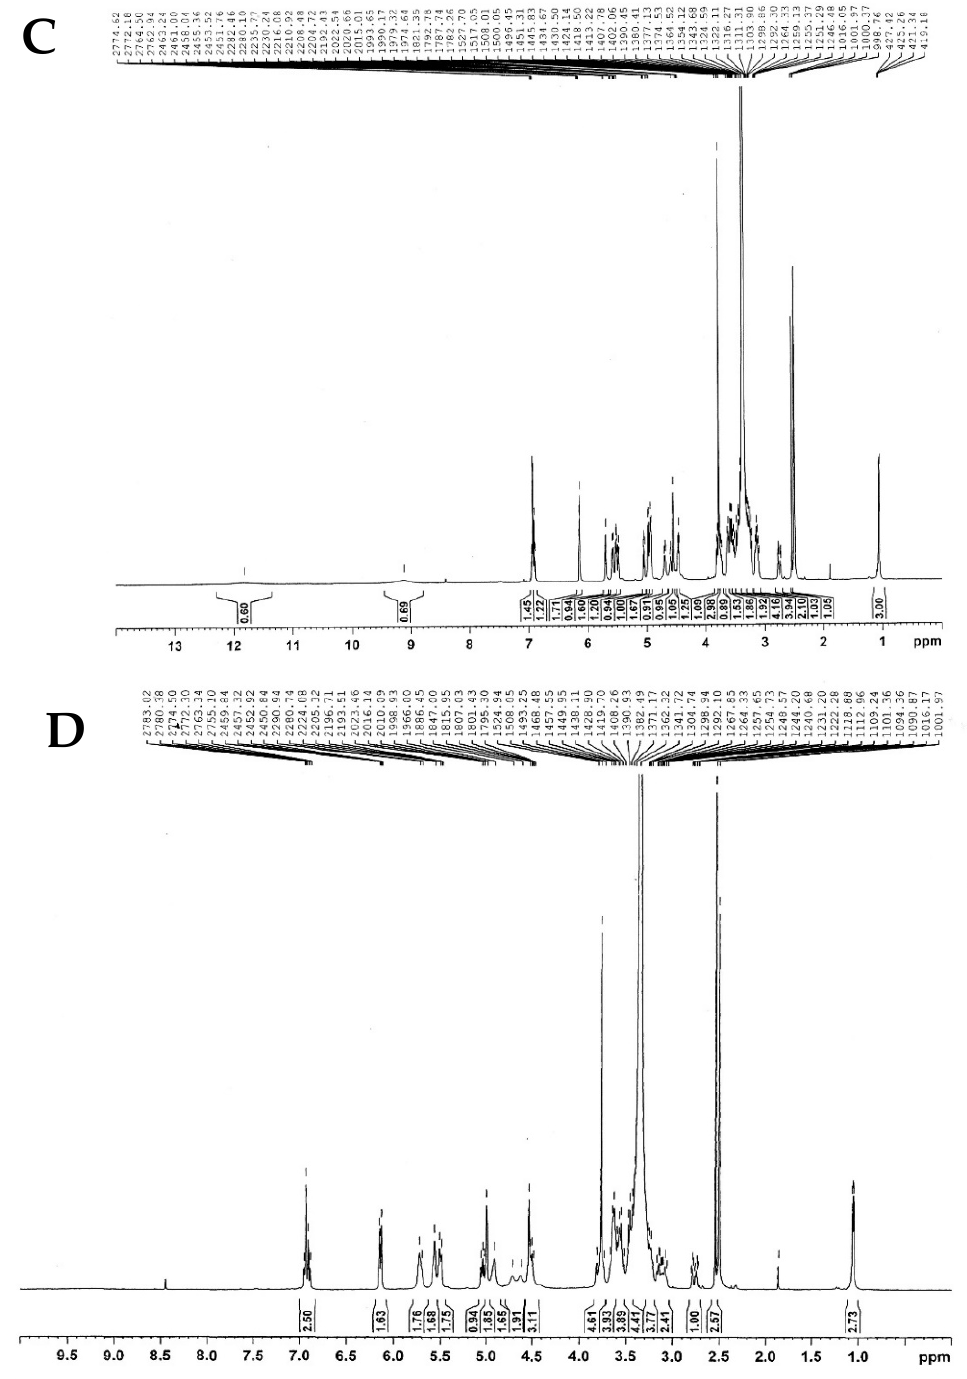
Figure 4. The 400 MHz 1 H-NMR spectra of ( A ) hesperetin, ( B ) hesperidin, ( C ) HG 1 , and ( D ) HG 2. In 13 C-NMR spectra, carbon signals for glycoside products at R t of 6.2 and 7.7 min were assigned to hesperidin glycosides. The peaks of HG 1–2 with chemical shifts at 60–61 ppm (–CH 2 OH), 103–197 ppm (aromatic carbon), and 99–101 ppm (α-anomeric carbon of glucose) were observed (Table 1 and Figure S1). From the result, the α-configuration of the D-glucose residue in HG 1 was identified by anomeric carbon of the glucose II signal (position C-1*) (Table 1 and Figure 5), which shifted from 92.77 to 101.25 ppm. In addition, comparing the position C-4″ of glucose I of hesperidin and HG 1 indicated that the carbon sidic form. For the 13 C-NMR spectrum of HG 2 , another α-1,4-glycosidic bond was con- 100.36 ppm. Moreover, position C-4* of HG 2 was shifted down from 70.32 to 79.23 ppm compared to HG 1 . From the combination of these results with enzymatic treatment and